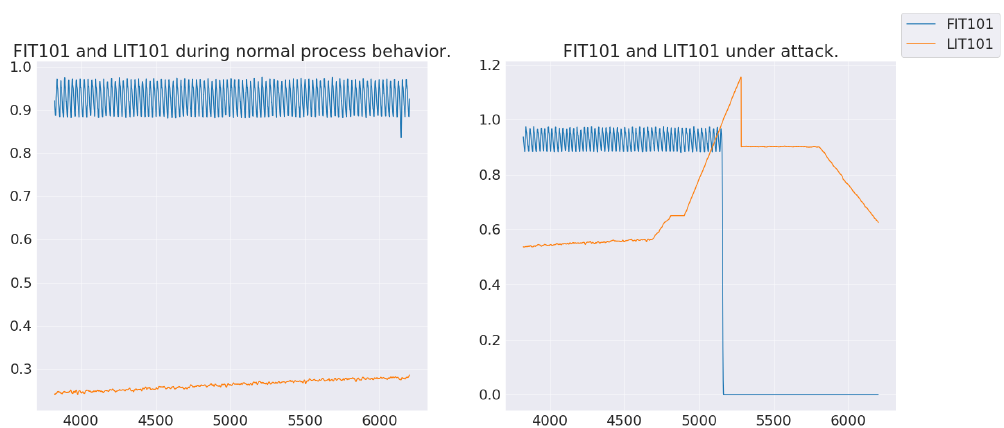
Figure 7. The relationship between LIT101 and FIT101 under normal behavior ( left ) and under stealthy attack on LIT-101 ( right